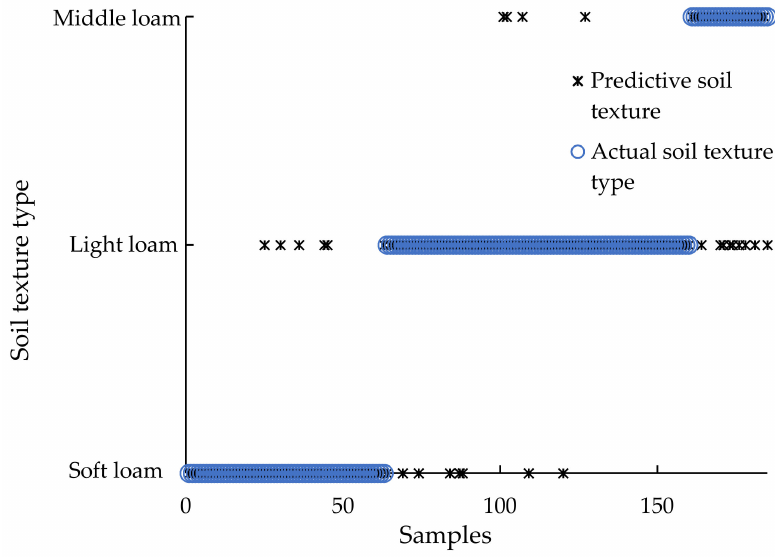
Figure 11. Soil texture measurement